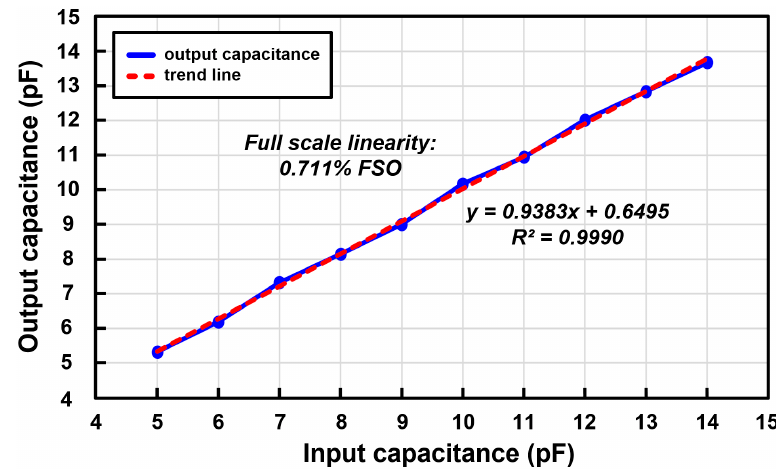
Figure 13. Linearity measurement results of the proposed reconfigurable sensor analog front-end.